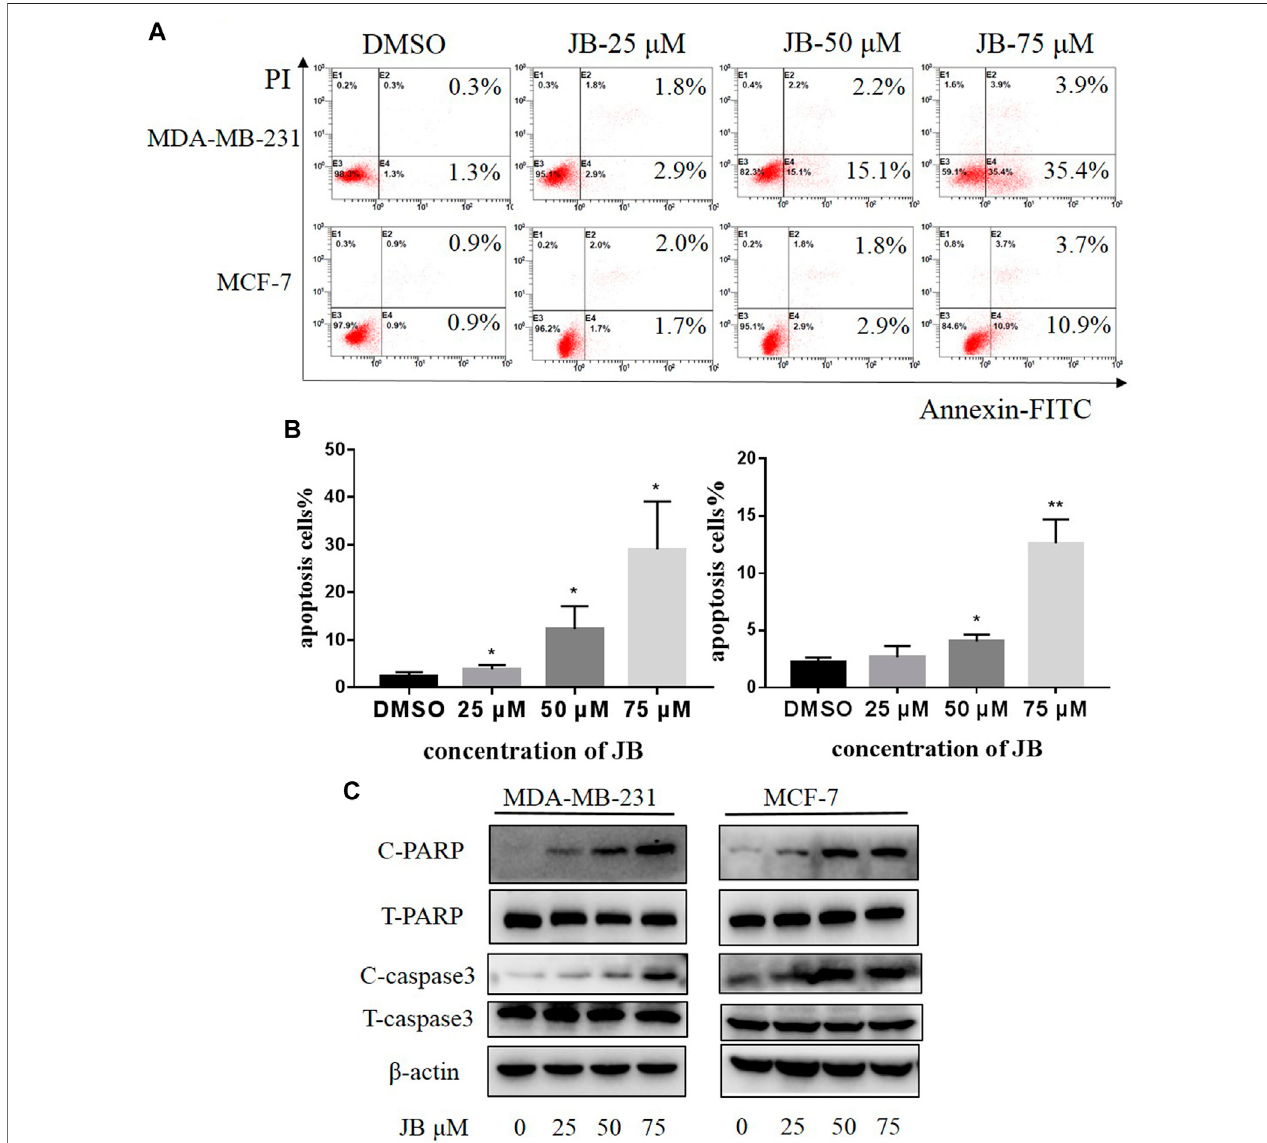
FIGURE2| JBinduces apoptosisinMDA-MB-231 and MCF-7celllines.CellsweretreatedwithDMSO orindicatedconcentrationsofJBfor48 h. Flowcytometry wasperformedtodetect theapoptotic cellpopulation percentage (A) . Statistical analysisofthe relative apoptotic percentage vs. DMSOwaspresentedbymean ± SEM (B) . Cleaved PARP, total PARP, cleaved caspase-3, and total caspase-3 were detected by western blot (C) . * p < 0.05 vs. DMSO group, ** p < 0.01 vs. DMSO group, *** p < 0.001 vs. DMSO group, n (cid:2)